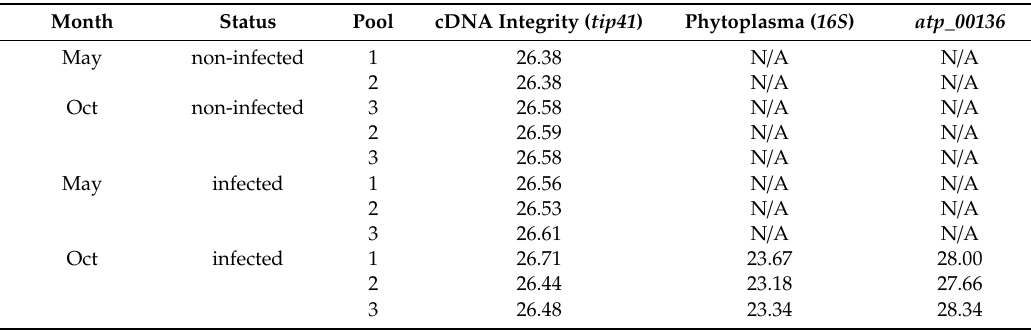
Table 1. Detection of atp_00136 in cDNA samples from infected and non-infected leaf tissue from May and October 2011. In May phytoplasma were only detectable in the roots but not in the leaves. atp_00136 was only detectable in P. mali-infected and colonized tissue. Cq values are given as the mean value of three repeated qPCR runs.